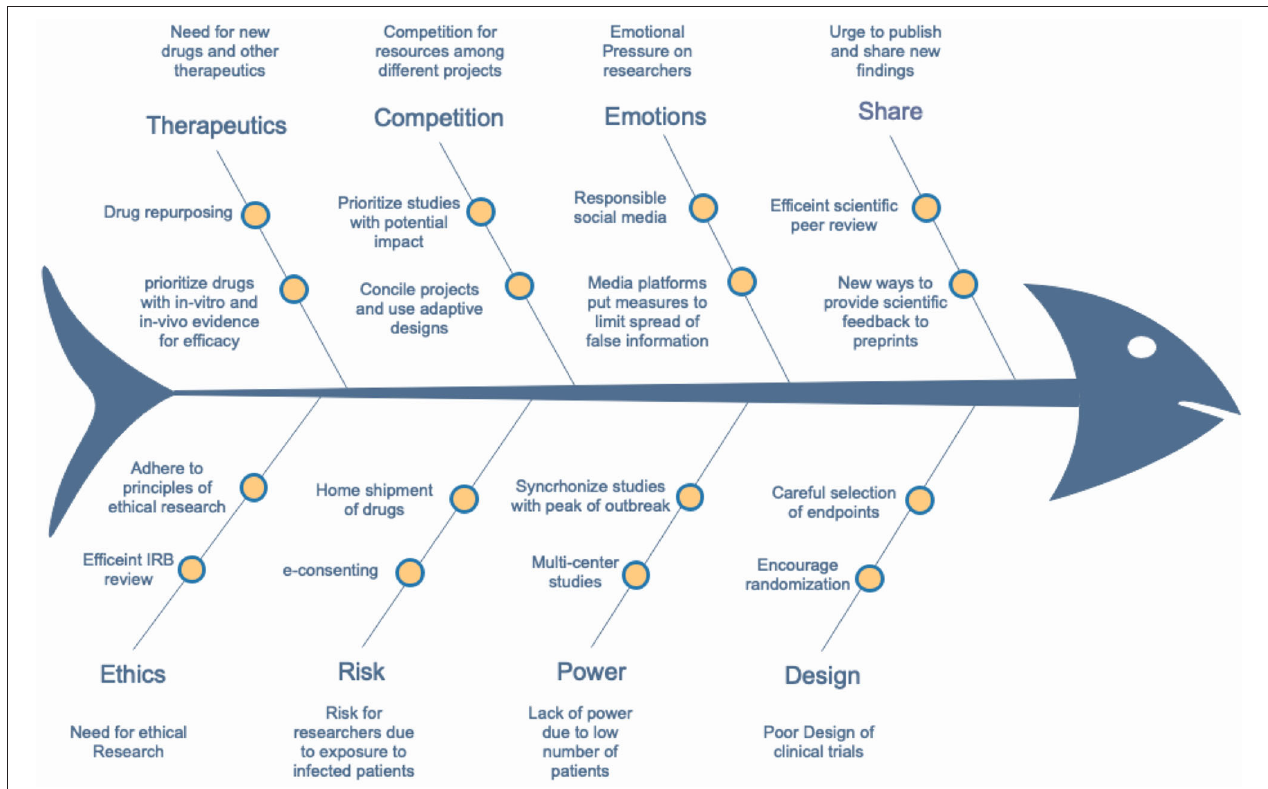
FIGURE 3 | A fishbone diagram showing the main obstacles for conducting efficient COVID-19-related research and some suggested